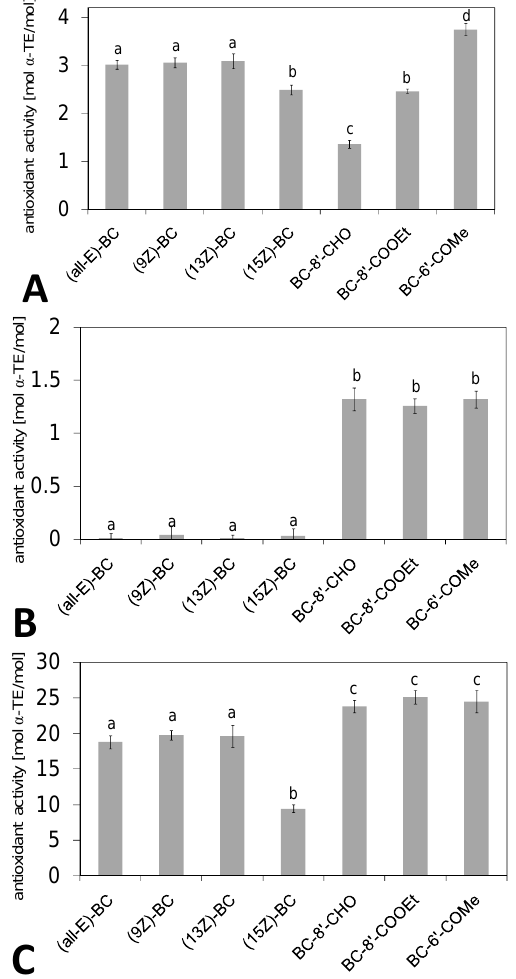
Figure 2. Antioxidant activities (mean ± SD) of β -carotene (BC) isomers and metabolites (at 10 µM) determined by α TEAC ( A ), FRAP ( B ) and CL ( C ) assay with respect to α -tocopherol ( α